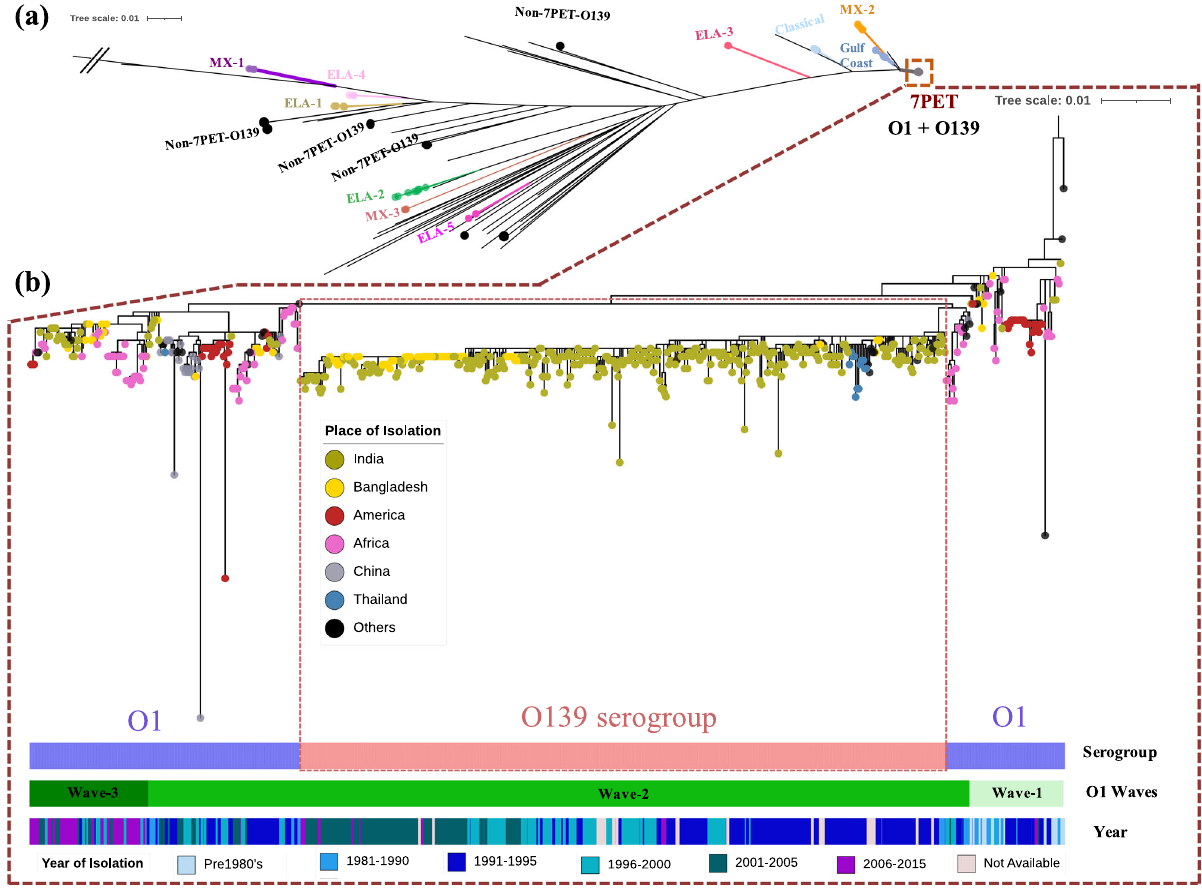
Fig. 1 Phylogenetic distribution of V. cholerae O139. a V. cholerae species phylogenetic tree constructed from a core gene SNP multiple sequence alignment. Colored branches represent V. cholerae serogroup O1 outbreak clades named as per previous publications, as labeled. Non-7PET V. cholerae O139 genomes are highlighted as black tree tips and the 7PET lineage is boxed. b Maximum likelihood phylogenetic tree of selected V. cholerae 7PET genomes. V. cholerae O139 ( n = 418) genomes were placed into the context of the 7PET phylogeny using representatives from waves 1 – 3 ( n = 259). The O139 sublineage is shown as a dashed box within the tree. Tree tips are colored by place of isolation (see key). Color bars depict the serogroup, transmission waves and year of isolation (see key). The tree was constructed from SNPs called against the V. cholerae N16961 reference genome and a pre- 7PET isolate, M66, was used as an out-group to root the tree. Recombination events were removed using Gubbins. The scale bar represents the number of substitutions per site per